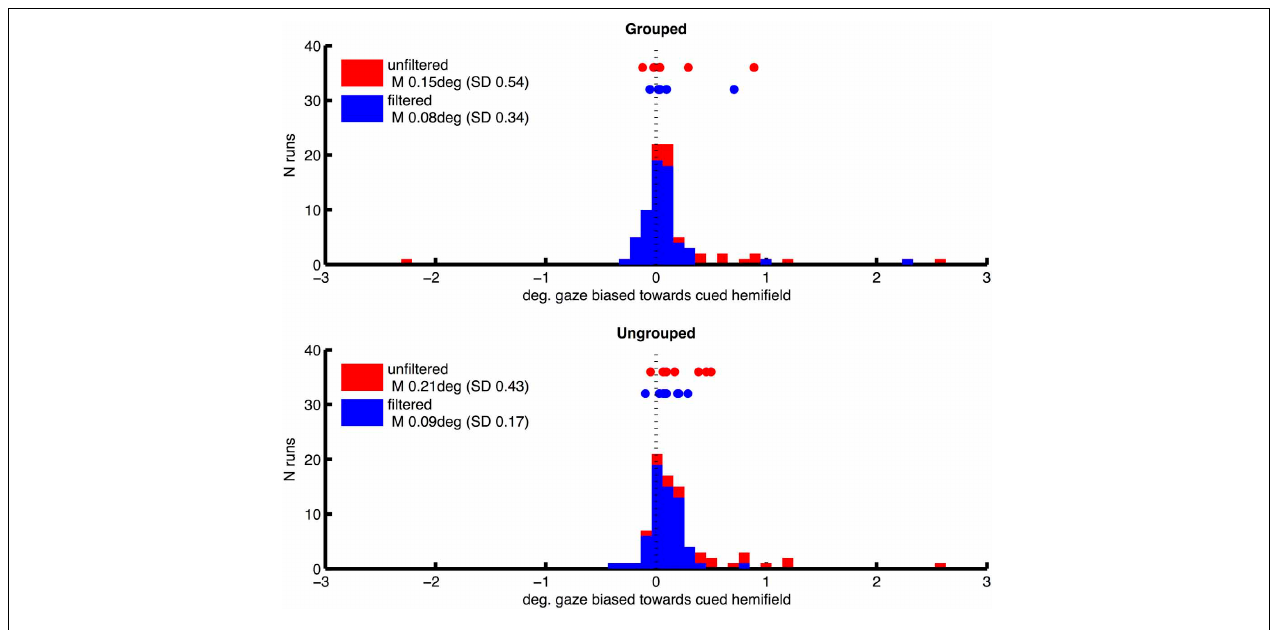
FIGURE 2 | Distribution of horizontal gaze locations relative to central fixation (0), toward the cued hemifield (positive values) or away (negative), in degrees of visual angle. Height of bars indicates the number of scanning runs associated with each gaze value. Distributions are shown